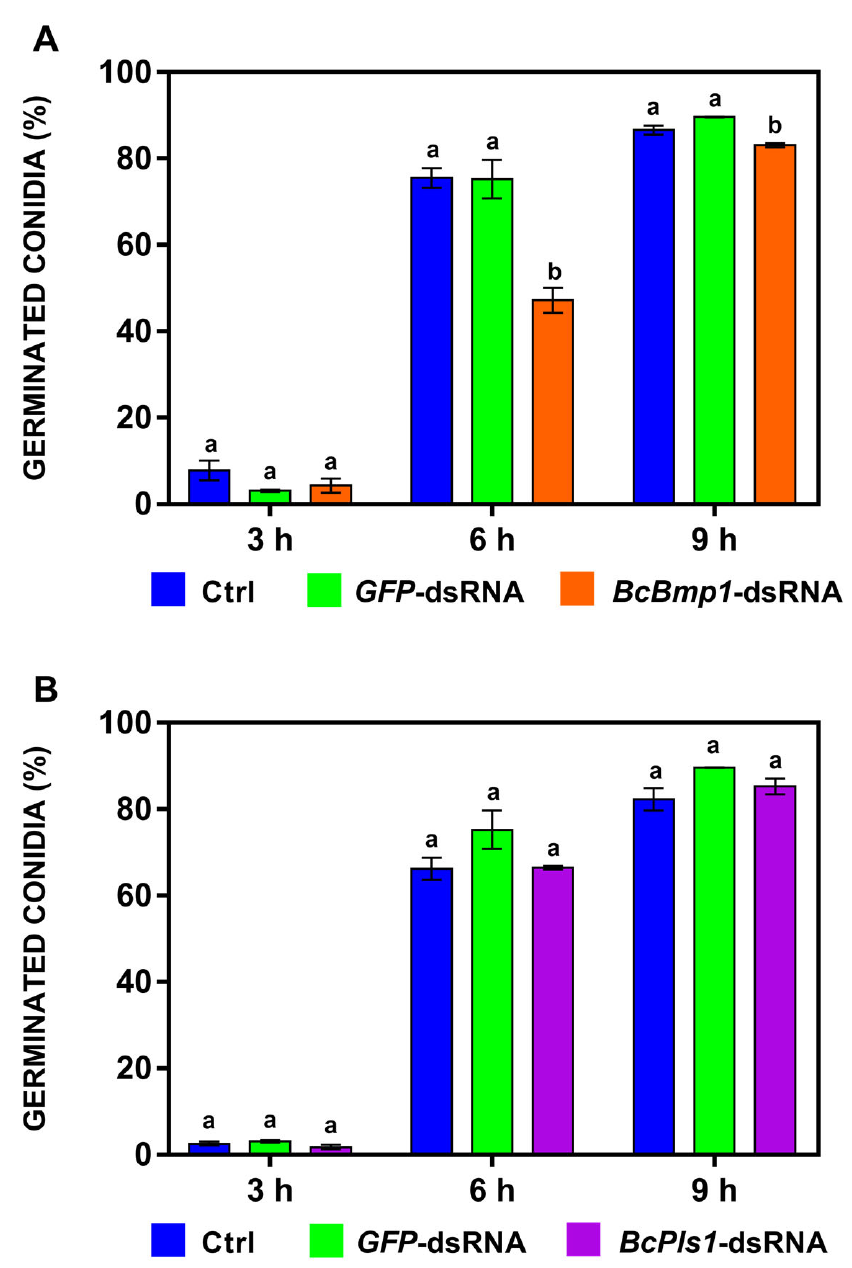
Figure 3. Germination kinetics of B. cinerea B05.10 conidia (1 × 10 6 ) on liquid SMB in 96-well polystyrene microtiter plates in the presence of ( A ) BcBmp1 -dsRNA (orange) and ( B ) BcPls1 -dsRNA (purple). In both graphs, the GFP -dsRNA (green) and control (Ctrl = SMB + TE buffer, blue) are reported. The graphs show the mean ( ± SE) of two independent experiments with three biological replicates ( n = 3; 200 conidia for each biological replicate were counted). Same letters above the bars indicate no significant differences from each other (ANOVA) according to Tukey’s HSD test ( p ≤ 0.05). The statistical analysis was conducted separately for 3, 6, and 9 h. For the treatment with BcPls1- dsRNA, the conidial germination was not significantly delayed in the in vitro assay at any of the times tested (Figure